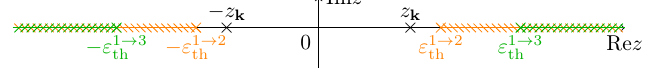
Figure 1: The analytic structure of the integrand of the self-energy Σ ( k ,i ħ h ω Matsubara integral over the imaginary axis can be performed by analytically contin- uing the Matsubara frequencies and computing a contour integral. The contours are chosen in such a way to avoid the poles of the single particle propagator, resulting in the two keyhole contours and used respectively in the first and second term of C 1 C 2 Eq. (16).